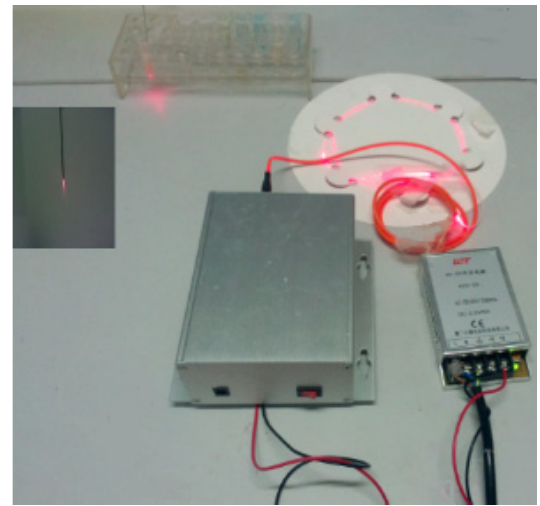
Fig. 1. Image of the acupuncture needle